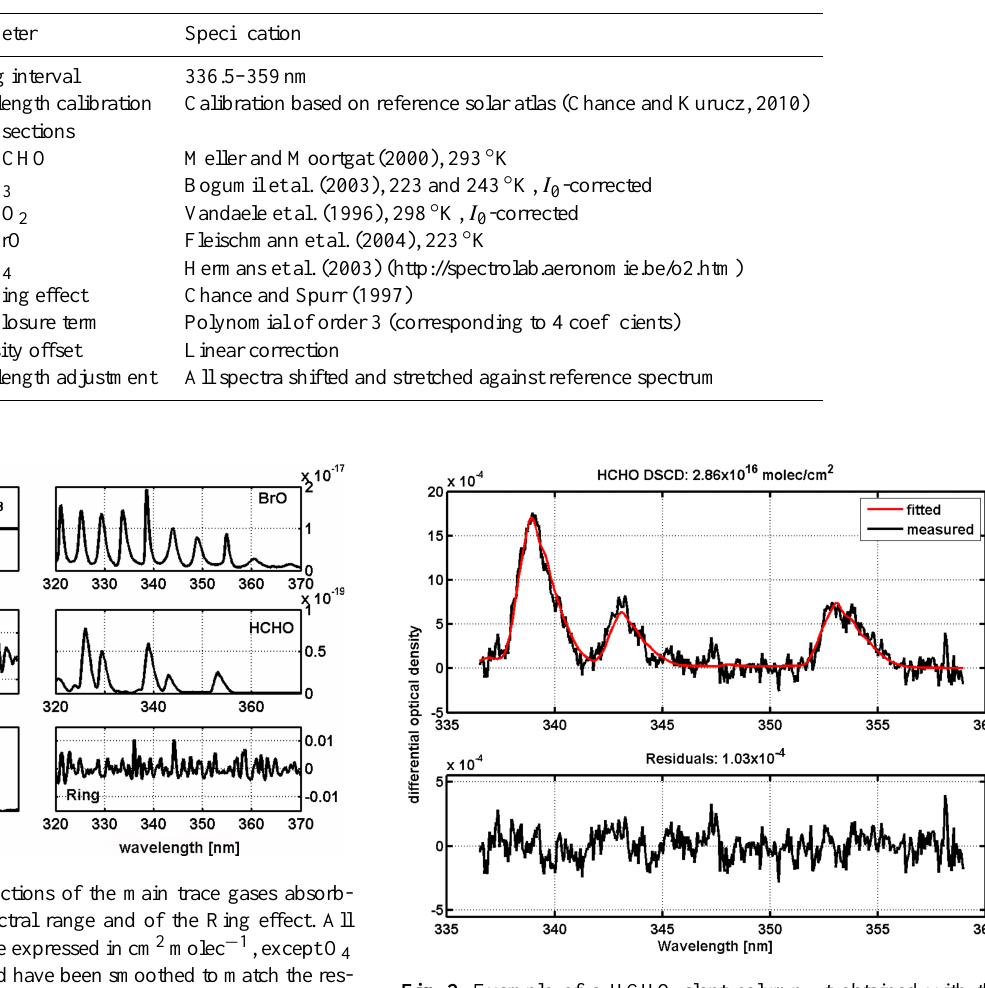
Fig. 2. Example of a HCHO slant column fit obtained with the BIRA-IASB instrument on 30 June 2009, around 14:30UT, at 4 ◦ elevation angle and 43 ◦ solar zenith angle. The first panel shows the measured (black) and the fitted (red) values, and the second panel shows the residual of the DOAS